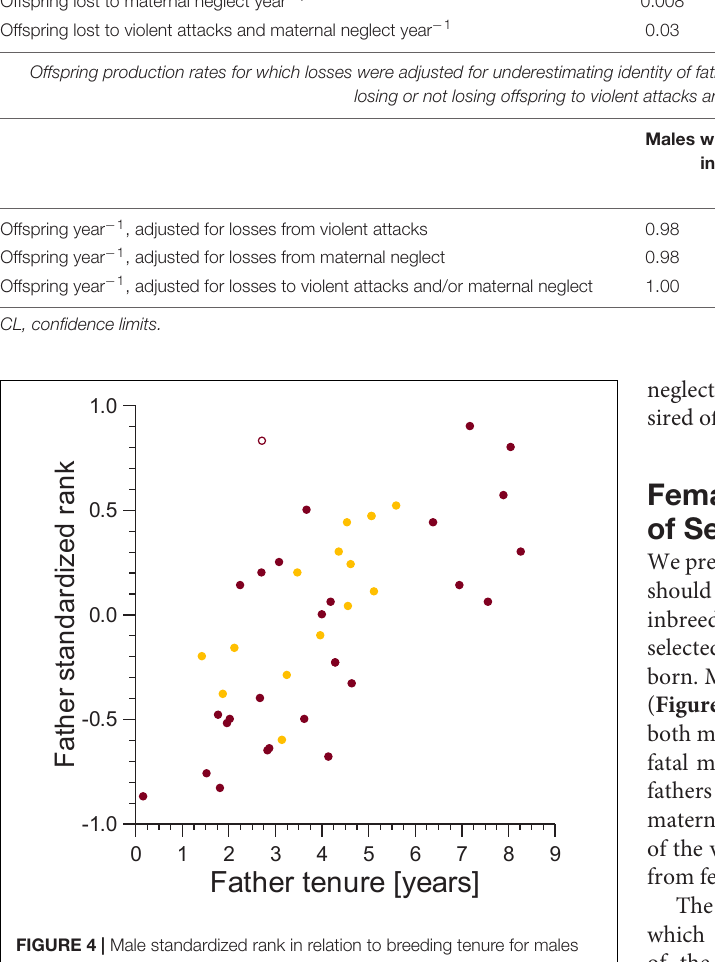
of different females (mean number 0.64 year − 1 , 95% CL